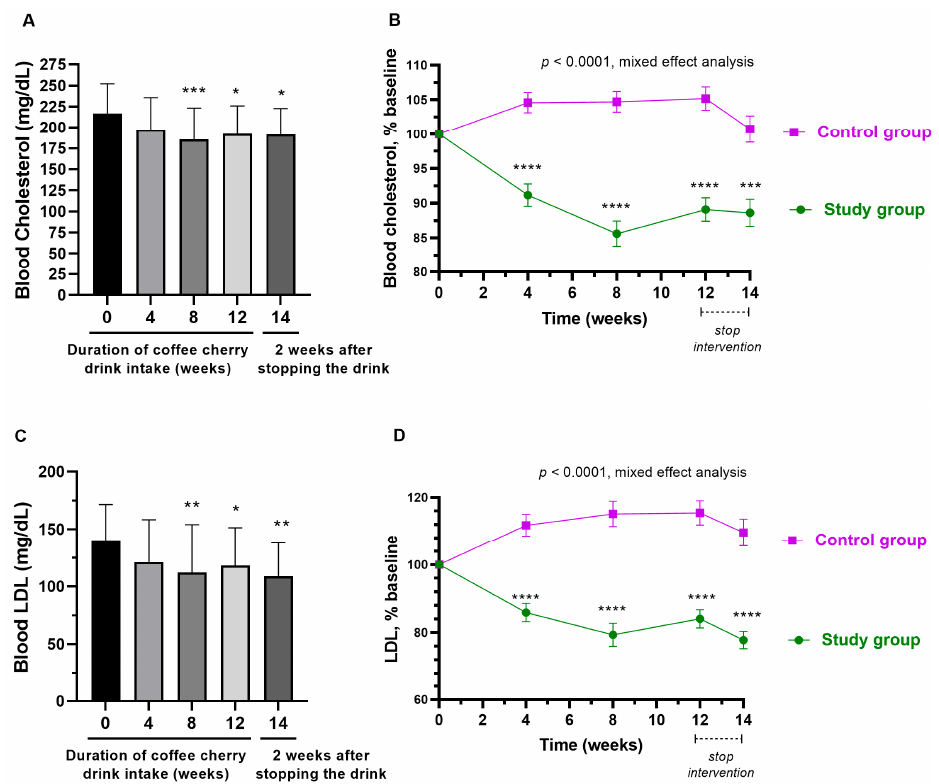
Figure 5. Changes in total cholesterol and LDL. The bar graphs show the mean and standard deviation of total cholesterol ( A ) and LDL ( C ) after consumption of cherry coffee pulp juice concentrate for 4, 8, and 12 weeks, and 2 weeks after stopping the intervention (14 weeks), with p -value obtained from the Kruskal–Wallis test; the line graphs show a comparison of the mean and standard deviation of the total cholesterol ( B ) and LDL ( D ) in the percentage of the respective baseline values (% baseline) at each time point between study (green) and control (purple) groups, with p -value obtained from mixed-effect analysis. *, **, ***, and **** mean p < 0.05. 0.01, 0.001, and 0.0001, respectively.